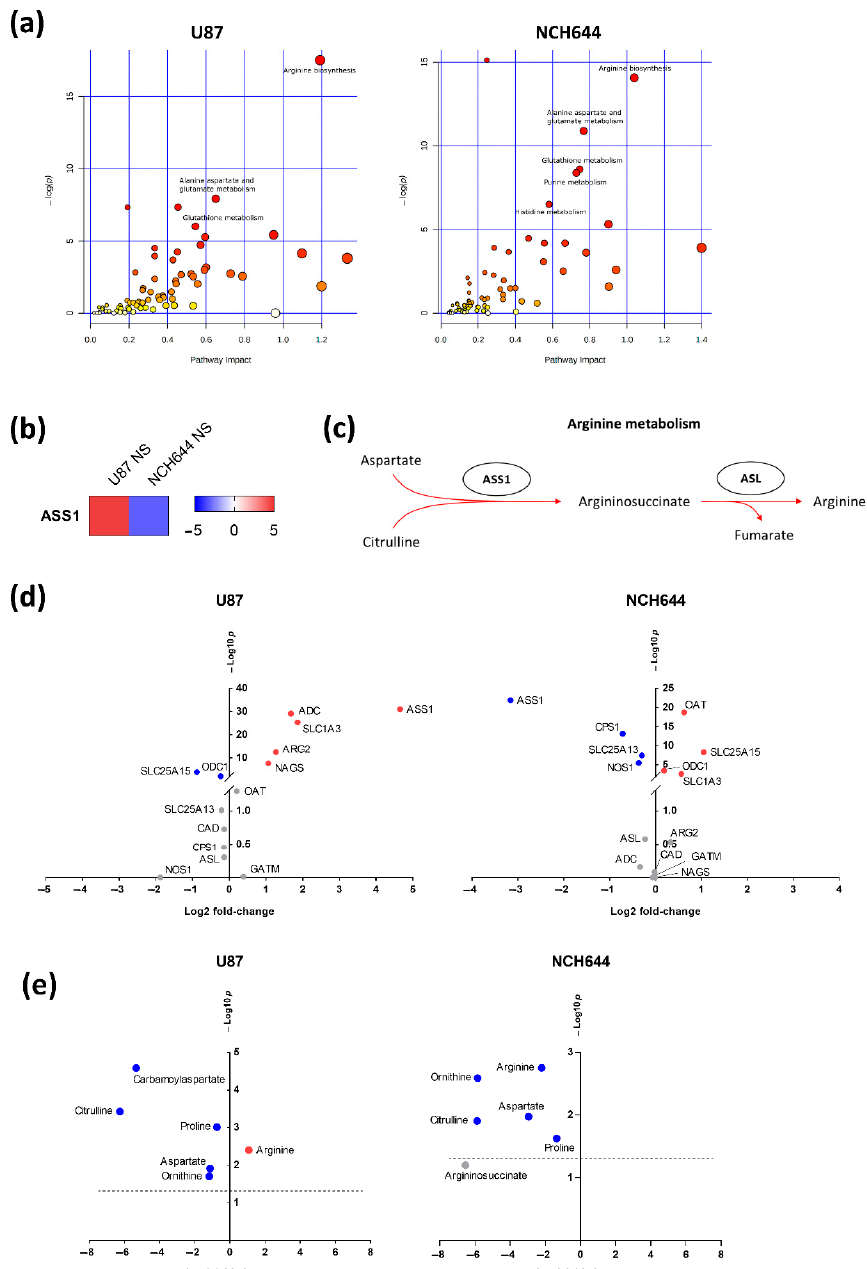
Figure 5. Joint pathway analysis of NS vs. ML reveals arginine biosynthesis as the most significantly regulated pathway. ( a ) Joint pathway analysis of significantly regulated metabolites (FDR < 0.05) and genes (FDR < 0.05, log2FC > ±1) in NS vs. ML from U87 and NCH644 cells. ( b ) ASS1 is significantly upregulated in U87 NS and downregulated in NCH644 NS, compared to ML cells (FDR < 0.05). ( c ) Schematic view of the arginine biosynthesis process. ( d ) Significantly upregulated (red) and downregulated (blue) genes involved in arginine metabolism, in NS vs. ML from U87 and NCH644 cells (FDR < 0.05). ( e ) Metabolites involved in arginine metabolism whose levels are significantly increased (red) and decreased (blue), in NS vs. ML from U87 and NCH644 cells (FDR < 0.05); n = 3. ADC—arginine decarboxylase; ARG—arginase; ASL—argininosuccinate lyase; ASS1—argininosuccinate synthase; CAD—carbamoyl-phosphate synthetase 2, aspartate transcarbamylase and dihydroorotase; CPS1—carbamoyl-phosphate synthase 1; GATM—Glycine Amidinotransferase; NAGS—N-acetylglutamate synthase; NOS1—nitric oxide synthase 1; OAT—ornithine aminotransferase; ODC1—ornithine decarboxylase 1; SLC1A3—solute carrier family 1 member 3; SLC25A13—solute carrier family 25 member 13;